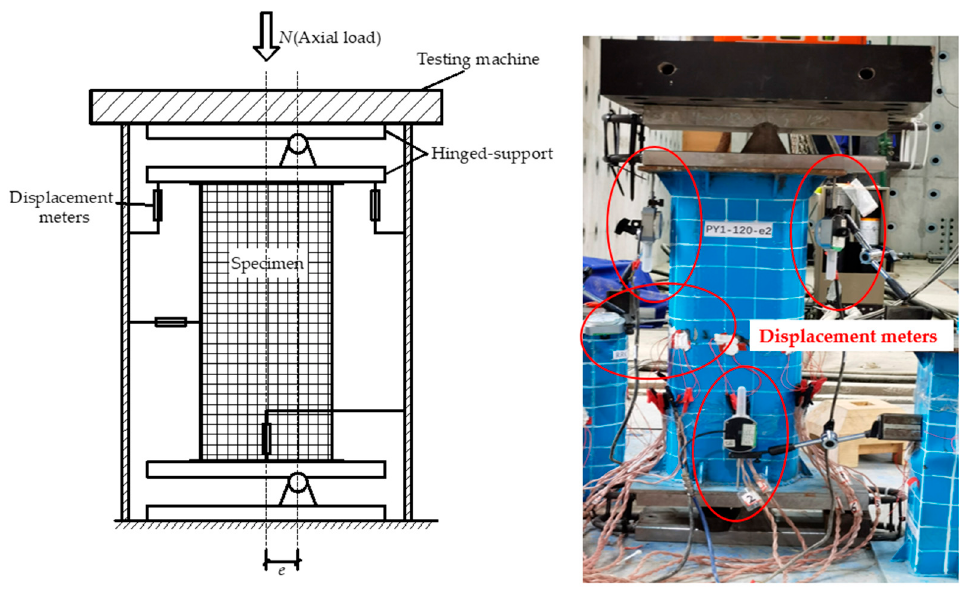
Figure 2. Test setup.